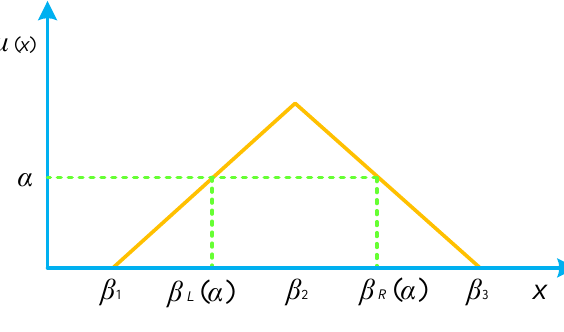
Fig. 1. Alpha-Cut of triangular fuzzy